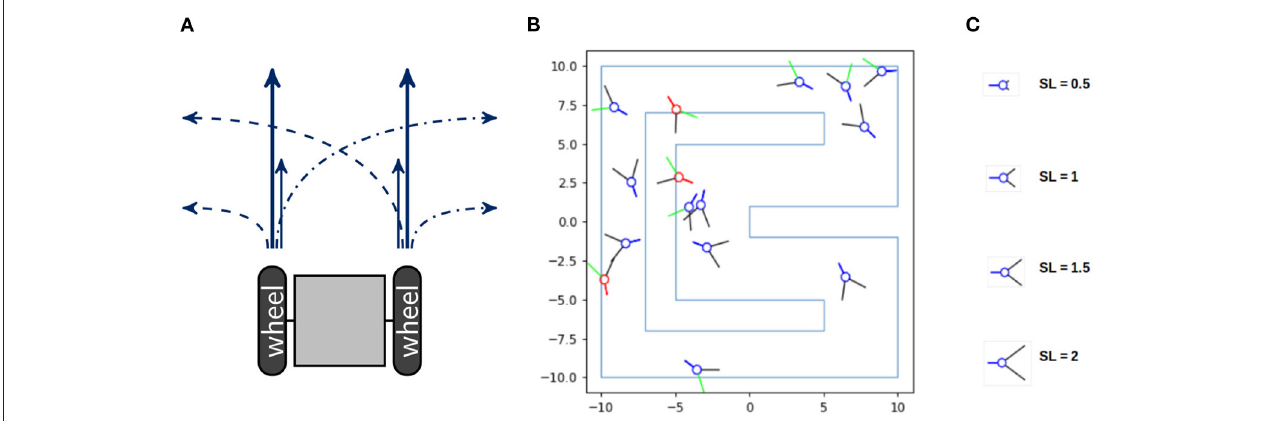
FIGURE 1 | (A) A sketch of a two-wheeled robot and its four different types of movement. (B) The racetrack the agents have to survive in and (C) the different sensor lengths, named SL, on the